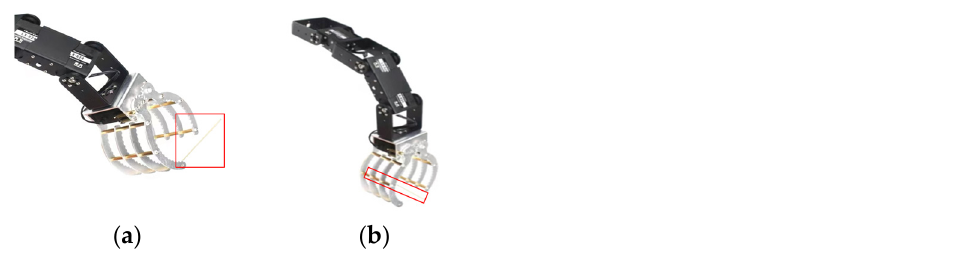
Figure 1. Grabbing with horizontal and oriented detection box. ( a ) Horizontal detection box; ( b ) oriented detection